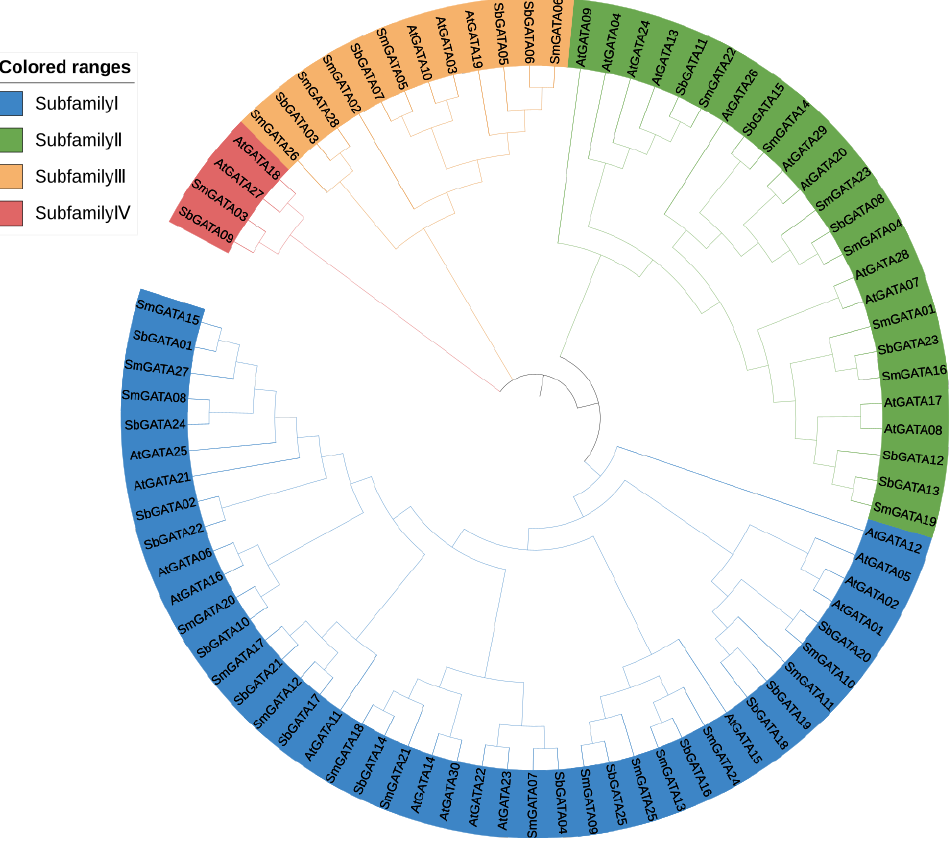
Figure 1. Phylogenetic analysis of GATAs from A. thaliana , S. bowleyana and S. miltiorrhiza . The phylogenetic tree was drawn using MEGA7.0 with maximum likelihood and 1000 bootstrap replicates. Four subfamilies were distinguished by different-colored arcs.